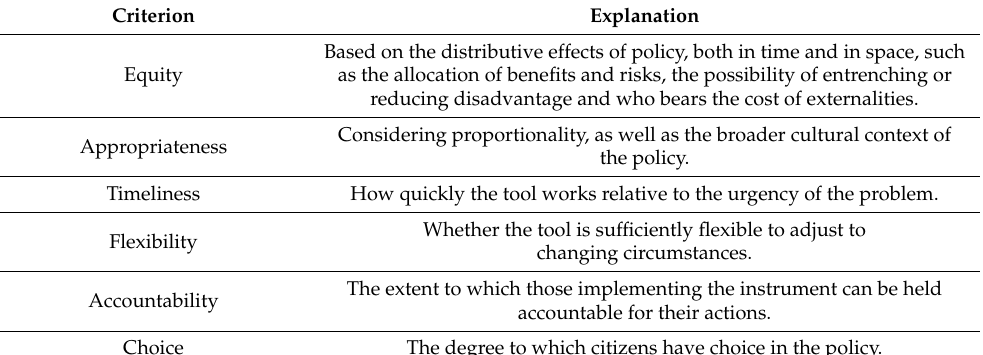
Table 1. Cont. Criterion Explanation Based on the distributive effects of policy, both in time and in space, such Equity as the allocation of benefits and risks, the possibility of entrenching or reducing disadvantage and who bears the cost of externalities. Considering proportionality, as well as the broader cultural context of Appropriateness the policy. Timeliness How quickly the tool works relative to the urgency of the problem. Whether the tool is sufficiently flexible to adjust to Flexibility changing circumstances. The extent to which those implementing the instrument can be held Accountability accountable for their actions. Choice The degree to which citizens have choice in the